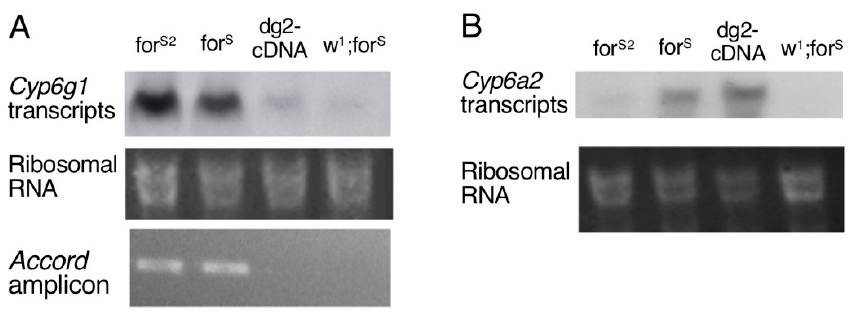
Figure 5. Expression profiles of Cyp6g1 and Cyp6a2. ( A ) Northern blot detection of Cyp6g1 transcripts and PCR detection of the Accord insertion in the Cyp6g1 promoter. ( B ) Northern blot detection of the Cyp6a2 transcripts. In both panels, the 18S RNAs used as controls show similar RNA loading in the lanes.